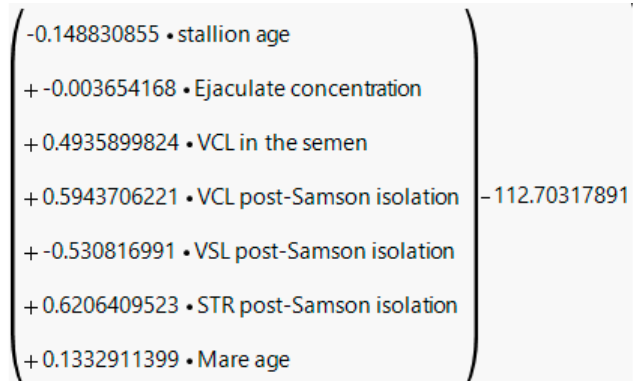
Figure A1. Equation generated when all continuous variables from the pre-chilled data set, were made available from all stallions achieving a predictive accuracy for the whole group of 76.1%.